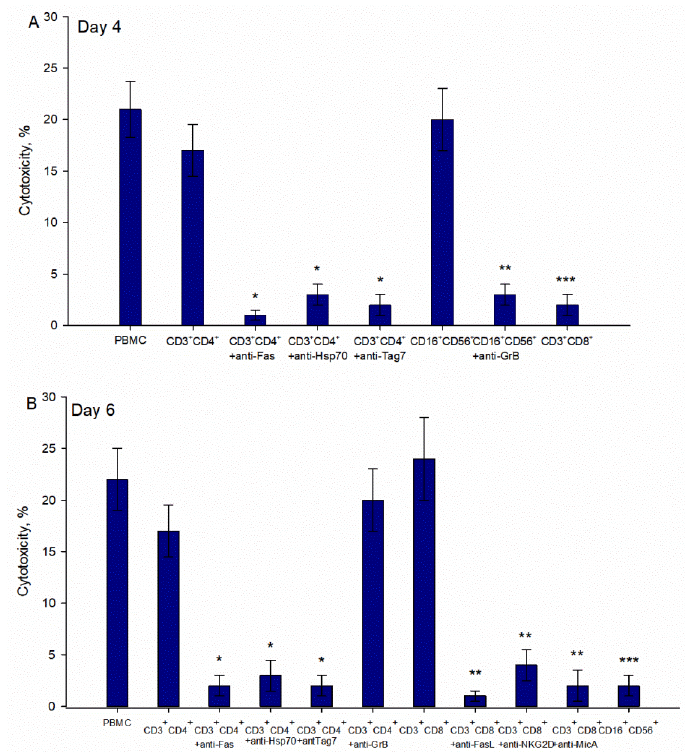
Figure 6. Cytotoxic activity of lymphocytes subpopulations after treatment of PBMCs with N3 pep- tide. Cytotoxicity of isolated CD16 + CD56 +, CD3 + CD4 +, CD3 + CD8 + lymphocytes from PBMCs incubated with N3 for 4 ( A ) and 6 ( B ) days. Subpopulations were isolated from N3 PBMCs using a Dynabeads negative isolation kit. Antibodies were added to target cells/lymphocytes before 1 h of cytotoxicity tests started. Cytotoxicity was measured after 24 h of incubation with K562 cells and after 3 h in tests with CD16 + CD56 + lymphocytes (one-way ANOVA, p -value: * < 0.05, *** < 0.05, ** < 0.03 vs PBMCs).